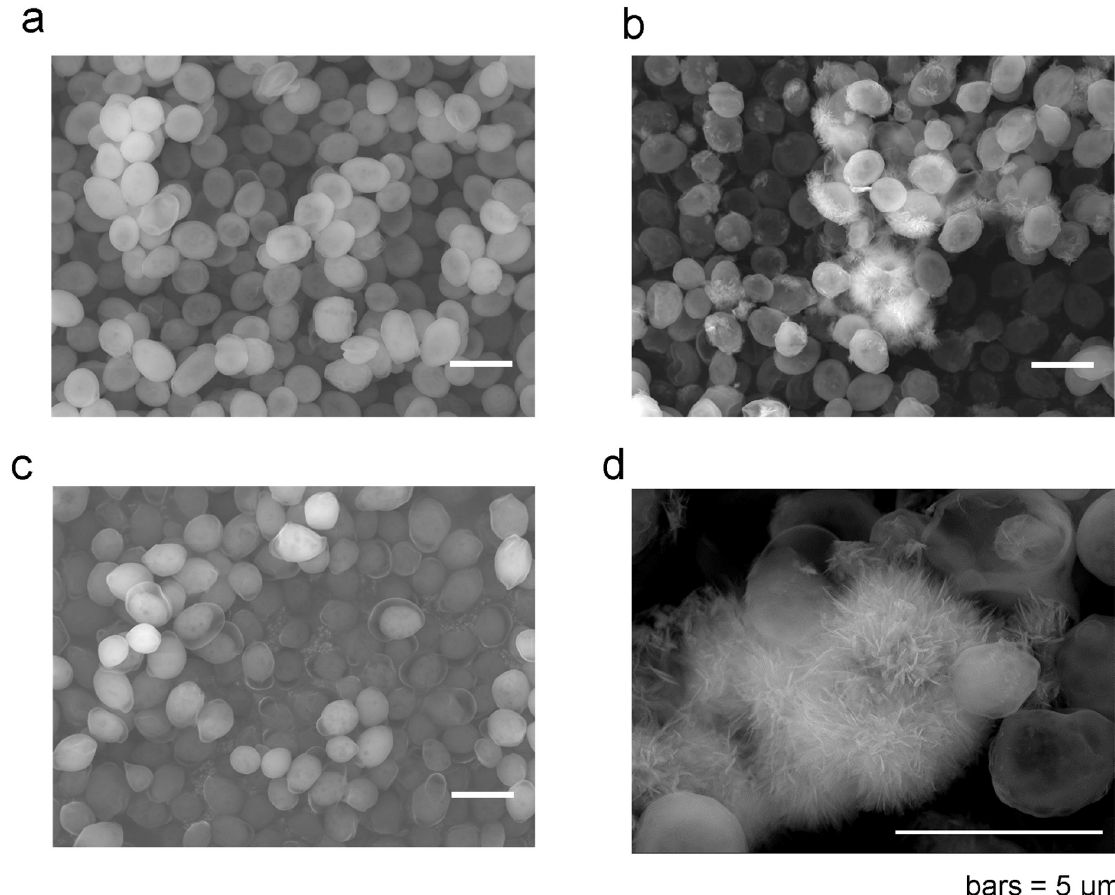
Fig 1. SEM images of dry baker’s yeast cells. (a) Phosphorylated yeast cells at 10 min during Cu 2+ adsorption. (b) Phosphorylated yeast cells on Day 6 during Cu 2+ adsorption. (c) Non-phosphorylated yeast cells on Day 6 during Cu 2+ adsorption. (d) Zoomed image of phosphorylated yeast cells on Day 6 during Cu 2+